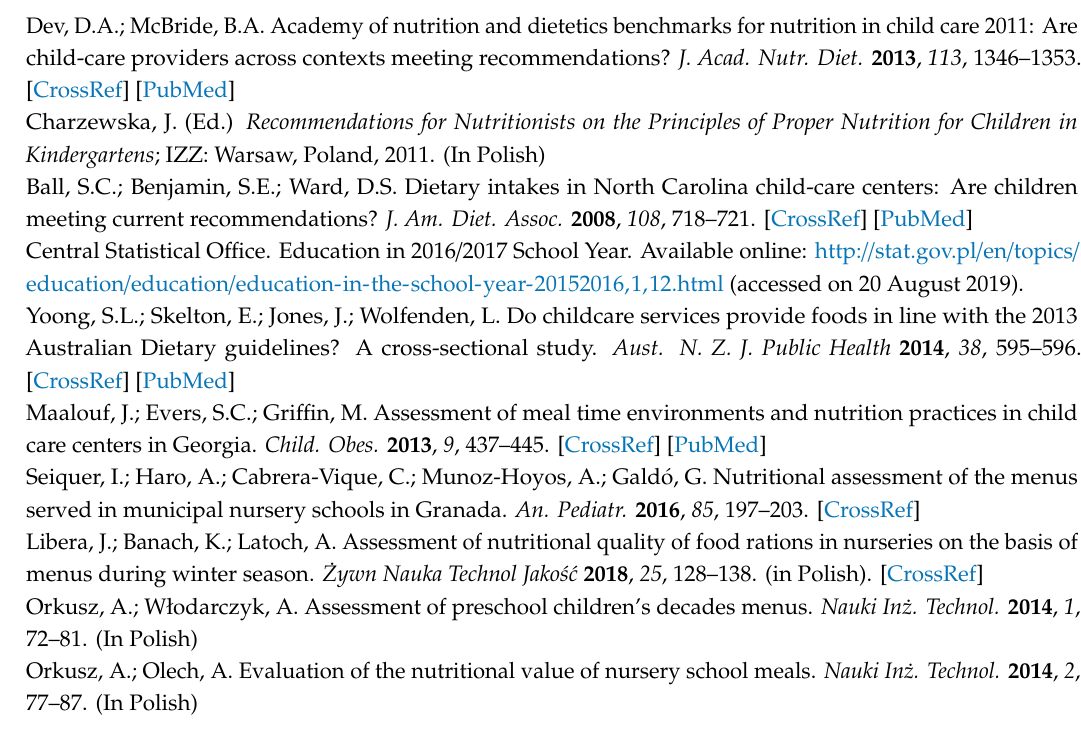
Figure S1: The overall scheme of the program, Table S1: The content of energy and nutrients presented (median and 25th and 75th percentiles) in menus before and after the education